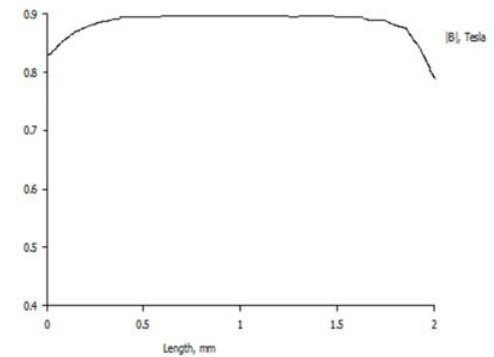
Fig. 12. Magnetic flux density(B) in FEMM software when I=2.5A.